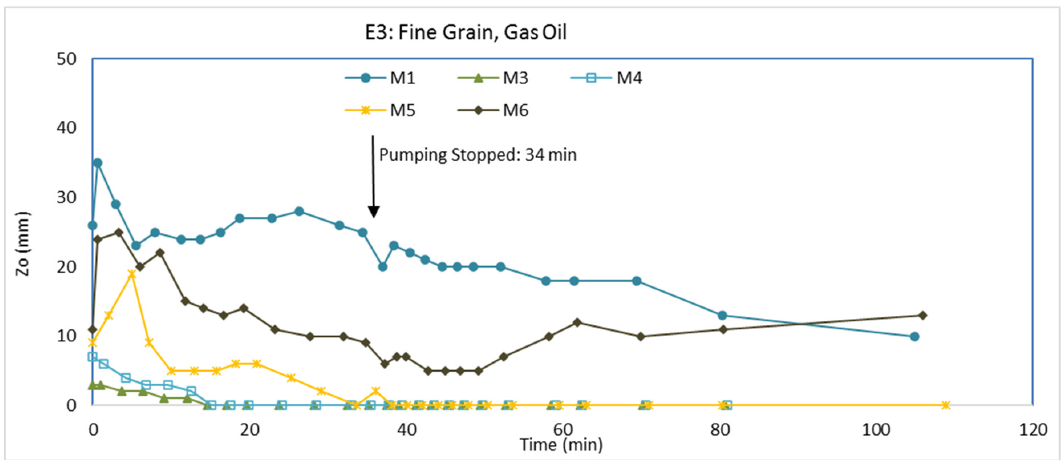
Figure 11. LNAPL thickness (Zo) variations in monitoring wells in E3.